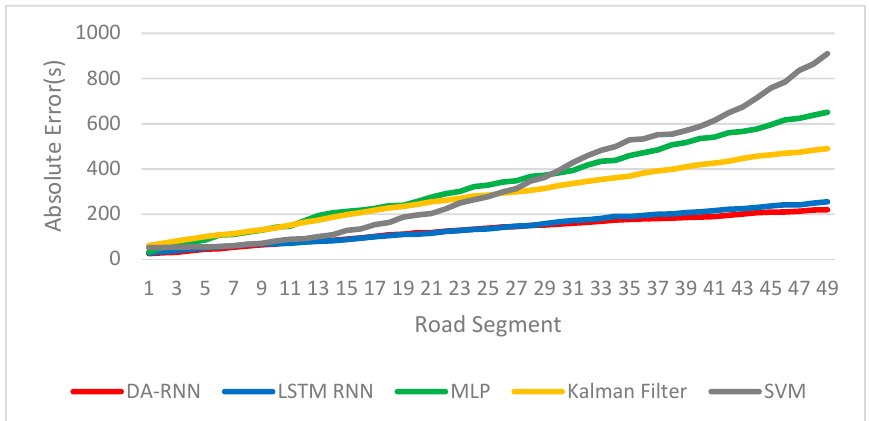
Figure 6. The accumulation of prediction error with the increase of stations under offline conditions. The MAE of the prediction by SVM has a tendency to rise faster with an increase of the number of stations. However, the MAE of the prediction from other methods increases almost linearly with the increase of the number of stations. Two RNN-based methods have a smaller MAE and a slower MAE growth rate.